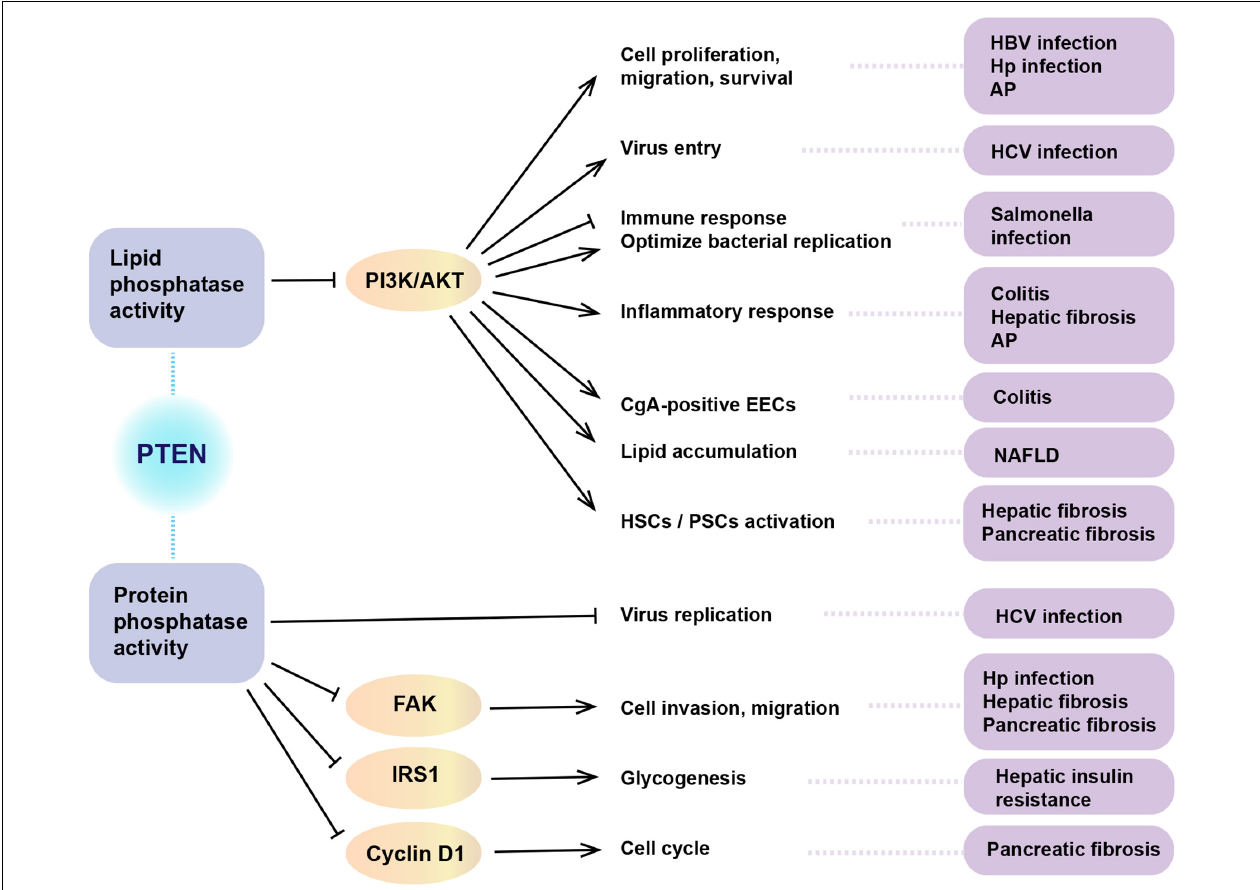
FIGURE 3 | The role of dual phosphatase activity of PTEN in non-neoplastic digestive diseases. PTEN acts in regulating a wide spectrum of biological functions. The above summarizes the biological role of PTEN in the pathogenesis of non-neoplastic digestive diseases via lipid or protein phosphatase activity. HBV, hepatitis B virus; HCV, hepatitis C virus; Hp, helicobacter pylori; AP, acute pancreatitis; NAFLD, non-alcoholic fatty liver disease; HSC, hepatic stellate cells; PSCs, pancreatic stellate cells; CgA, chromogranin A; EECs, enteroendocrine cells; PI3K, phosphatidylinositol 3-kinase; FAK, focal adhesion kinase 1; IRS1, insulin receptor